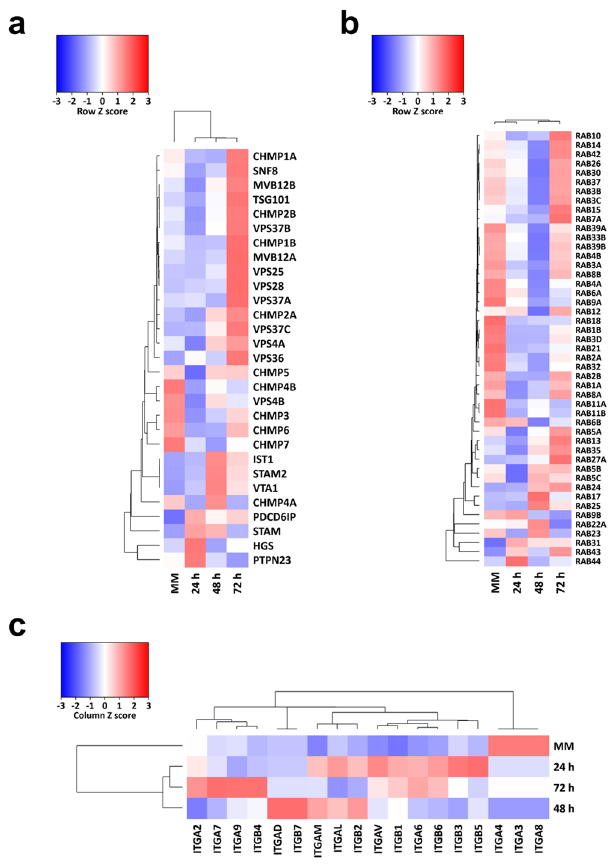
Figure 4. Exosomes from bovine milk are enriched with exosomal markers. ( a ) A heatmap showing enrichment of exosomal marker proteins in colostrum and MM exosomes. The scaled expression of each protein, denoted as the row Z-score , is plotted in the red–blue colour scale. High expression levels are indicated in red and low expression levels are shown in blue. Similar to western blot analysis, Alix (PDCD6IP) was found to be of higher abundance in the colostrum samples when compared with the MM samples. The 72 h colostrum samples had a higher level of many of the ESCRT component proteins. ( b ) Higher abundance of Rab family proteins was observed in both colostrum and MM exosomes. ( c ) An enrichment of integrins, which play a crucial role in exosomal uptake by target cells was observed in all the